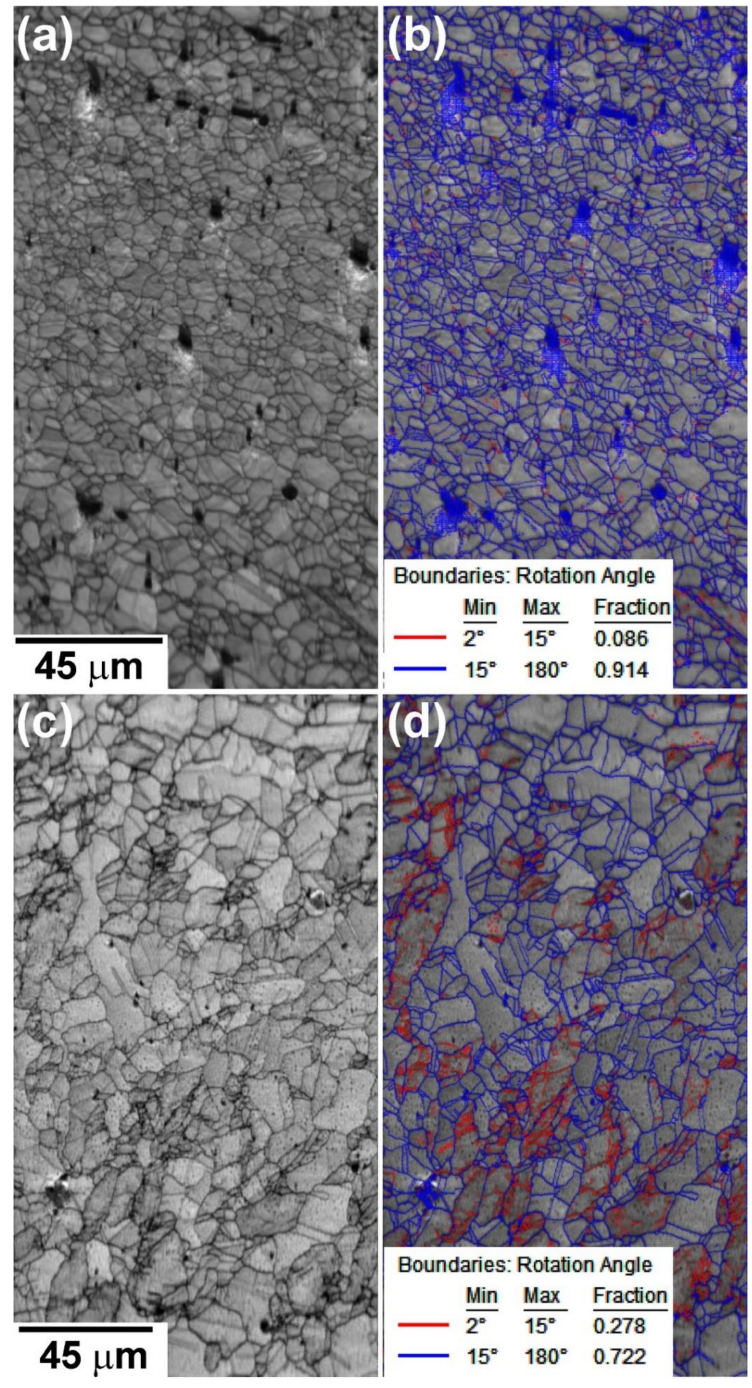
Figure 9. EBSD from samples water quenched after deformation with interpass time of 20 s and 13 passes: ( a , b ) for ISO steel (soaked at 1200 ◦ C); ( c , d ) for ISO steel (soaked at 1250 ◦ C). IQ map: ( a , c ). Orientation image mapping (OIM) showing high-angle (misorientations θ > 15 ◦ , blue lines) and low-angle (subgrains, 2 ◦ < θ < 15 ◦ , red lines) grain boundaries: ( b , d